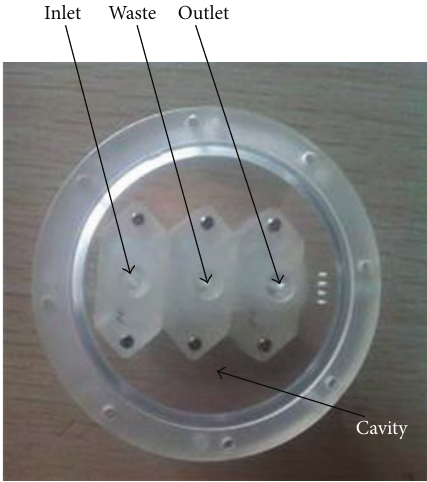
Figure 3: A photograph of cell culture cavity.